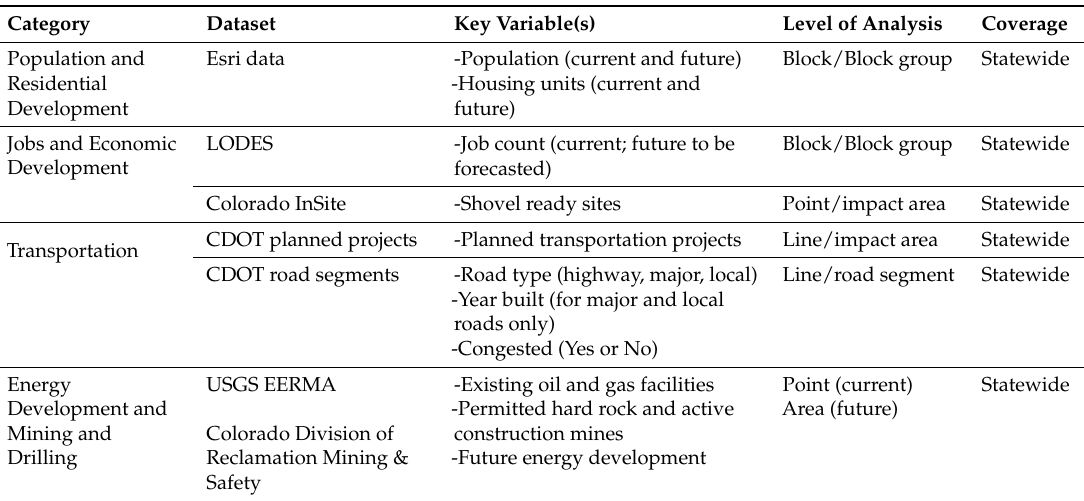
Table 1. Overview of demand-related